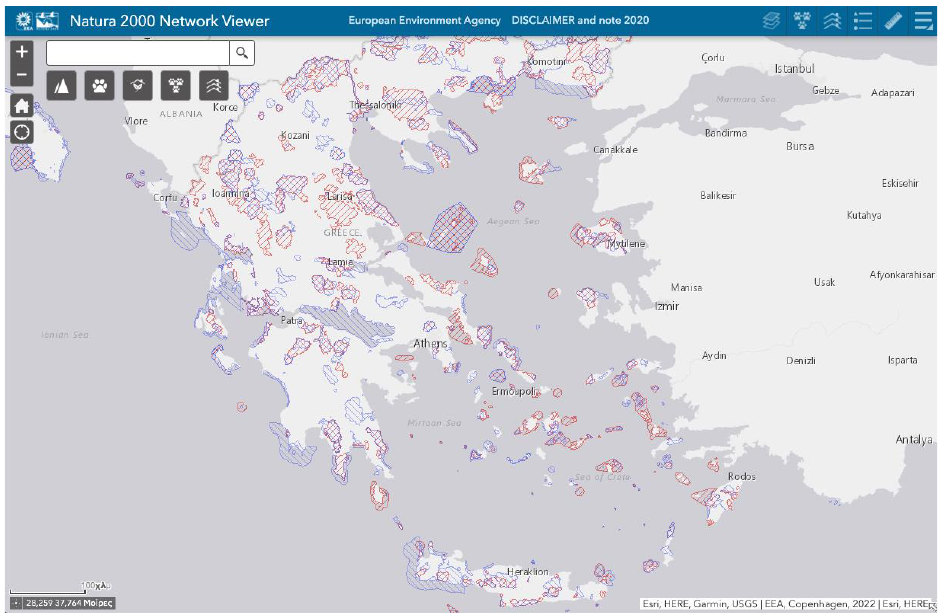
Figure 4. Natura 2000 Network Viewer. Reproduced from https://natura2000.eea.europa.eu/ (ac- cessed on 8 May 2021).